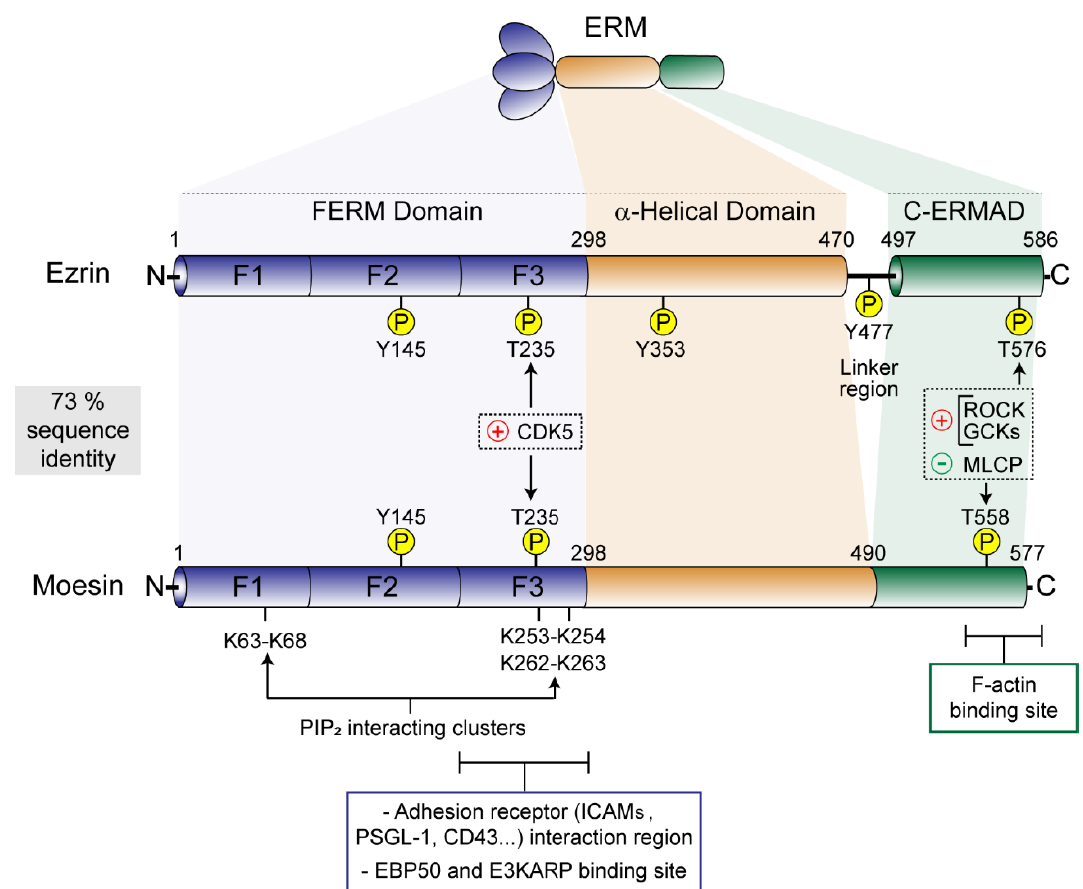
Figure 1. Schematic comparison of the conserved domain structure of human ezrin and moesin showing their sequence identity. The three subdomains (F1–F3) of the N-terminal band 4.1 protein ezrin, radixin and moesin (FERM) domain, the α-helical region, and the C-terminal ERM association domain (C-ERMAD) are depicted. Note that ezrin bears a linker region containing a regulatory Tyr (Y477) that is absent in moesin. The binding sites for PIP 2 , adhesion receptors and the PDZ domain-containing proteins EBP50 and E3KARP in the FERM domain, and for the F-actin binding site in the C-ERMAD, are shown together with the regulatory Tyr and Thr. Ser / Thr-specific ERM-associated kinases (CDK5, cyclin-dependent kinase 5; ROCK, Rho kinase; GCKs, germinal center kinases, e.g., LOK, lymphocyte-oriented kinase) and phosphatases (MLCP, myosin light chain phosphatase) are also depicted.